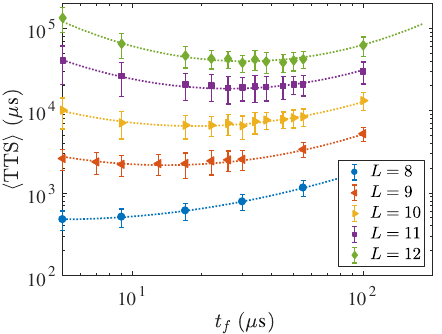
FIG. 22. Median TTS as a function of annealing time for hardware-planted instances on the DW2X. Unlike the DW2KQ, the optimal annealing time for L ¼ 8 appears to be smaller than 5 μ s; for L ≥ 9 the optimal annealing time t (cid:3) lies within the range of achievable annealing times for the DW2X device. Further- more, for the same problem size, the DW2X optimal annealing times are consistently smaller than those of the DW2KQ [compare to Fig. 15(b) and recall Fig. 16]. While the difference in the hardware graph may play a role in this, it is likely that the intrinsic differences between the two devices is responsible (see Appendix G 1 for additional this device. Note that because the hardware graph of the DW2X differs from that of the DW2KQ [see Figs. 10(a) and 10(b)], we should not assume that the instances defined on both are necessarily from the same class.